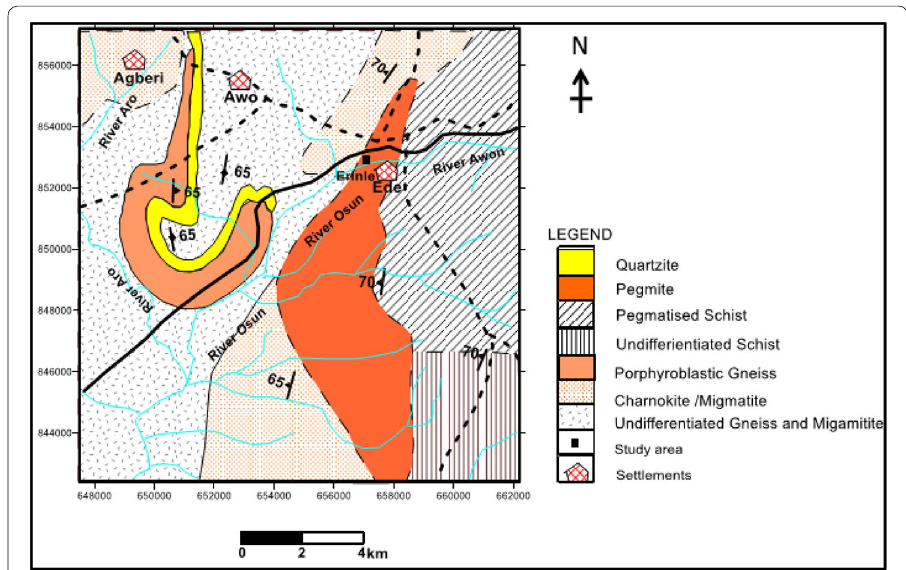
Fig. 5 Geological map of areas around Erinle (modified from Iwo Sheet 60, NGSA